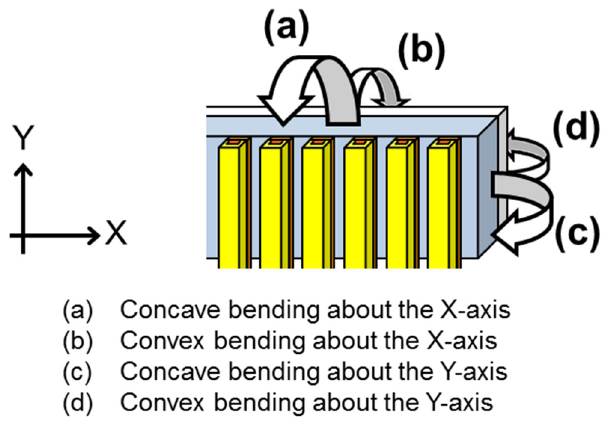
Figure 5. Schematic of the bending directions.